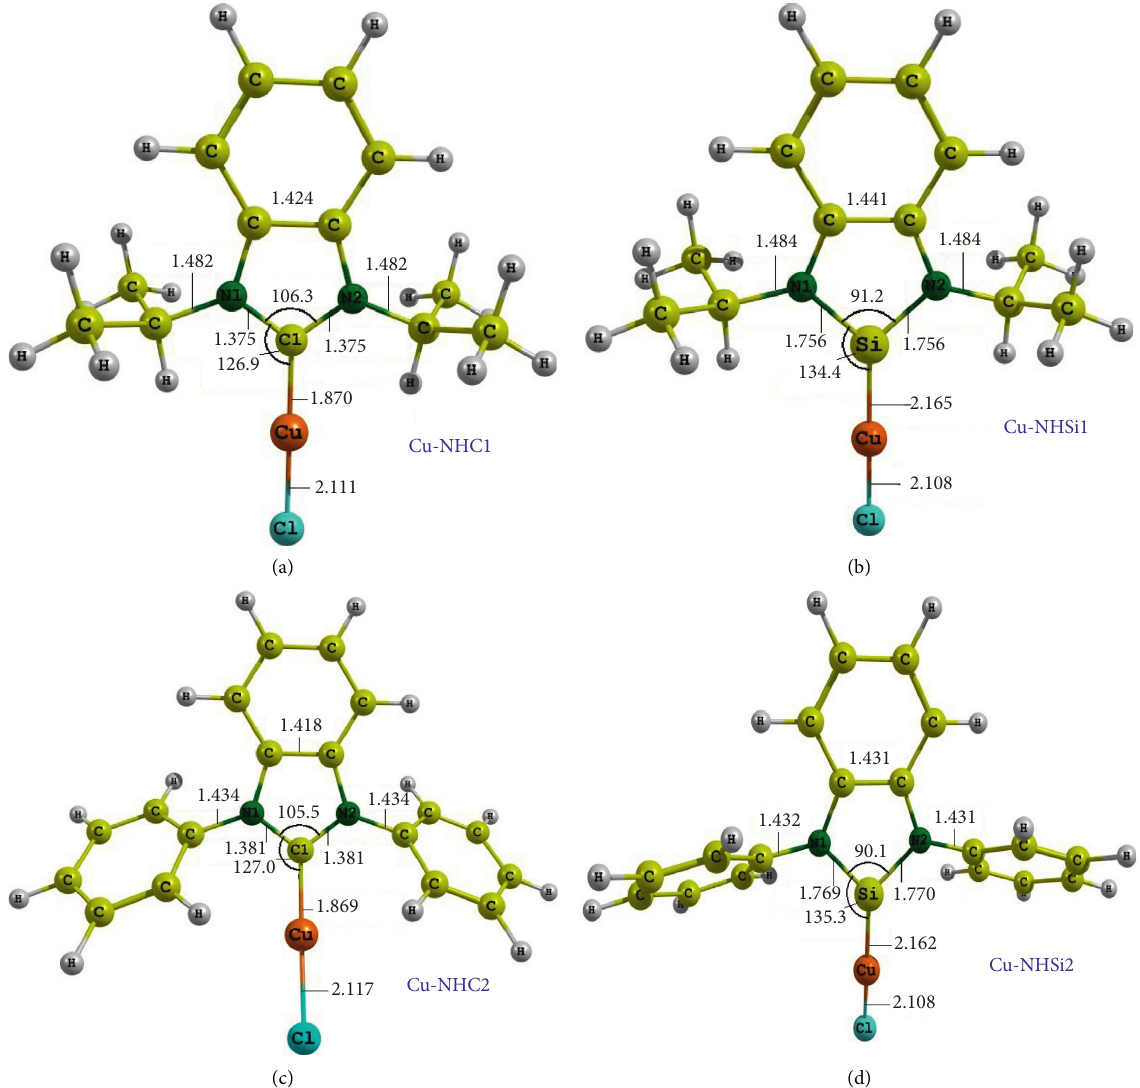
Figure 3: Optimised structures of copper chloride-carbenes (Cu-NHC1 and Cu-NHC2) and copper chloride-silylenes (Cu-NHSi1 and Cu- NHSi2) using BP86/def2-SVP